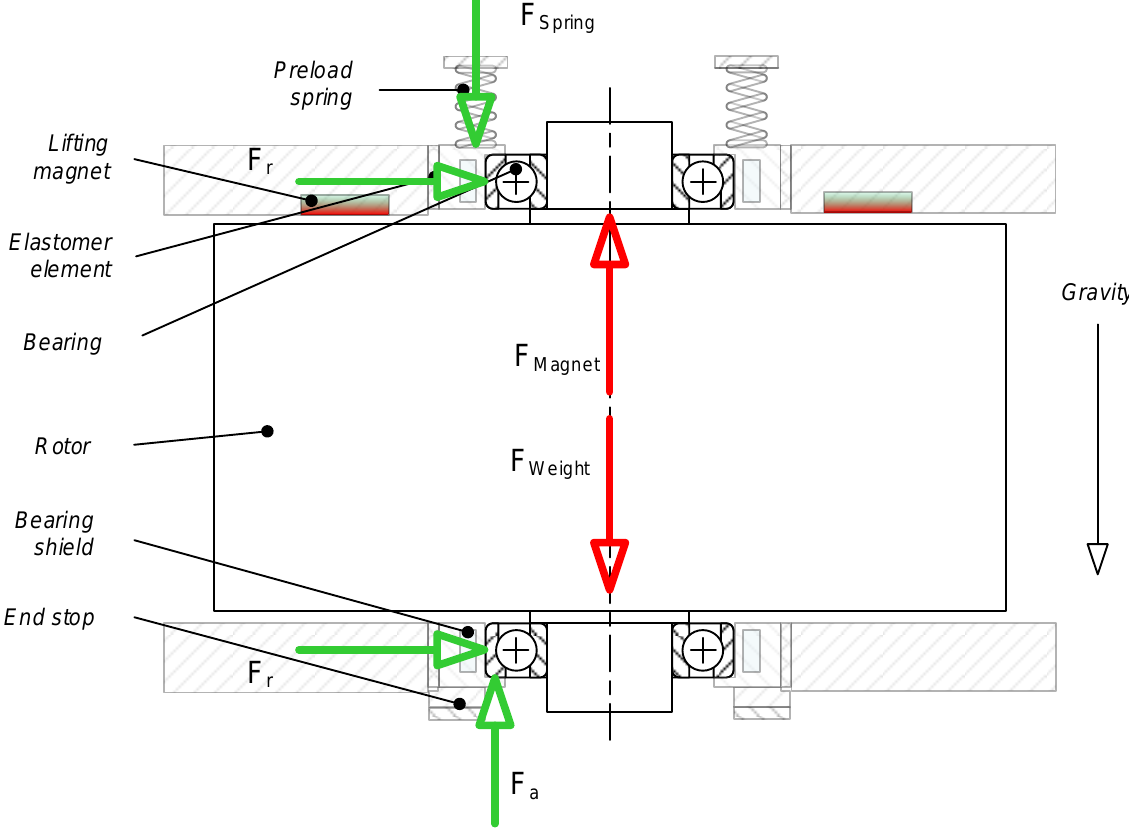
Figure 3. Schematic diagram of the rotor-bearing-system.